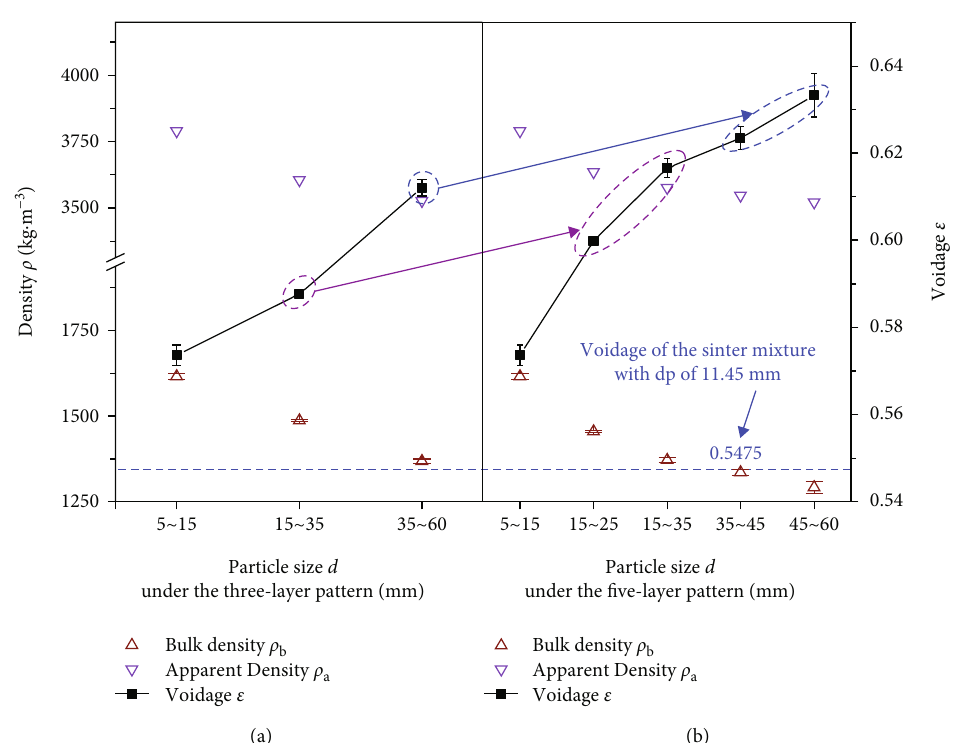
Figure 6: Characteristic parameters of the sinter in each particle size range under the three-layer pattern (a) and the fi ve-layer pattern (b).